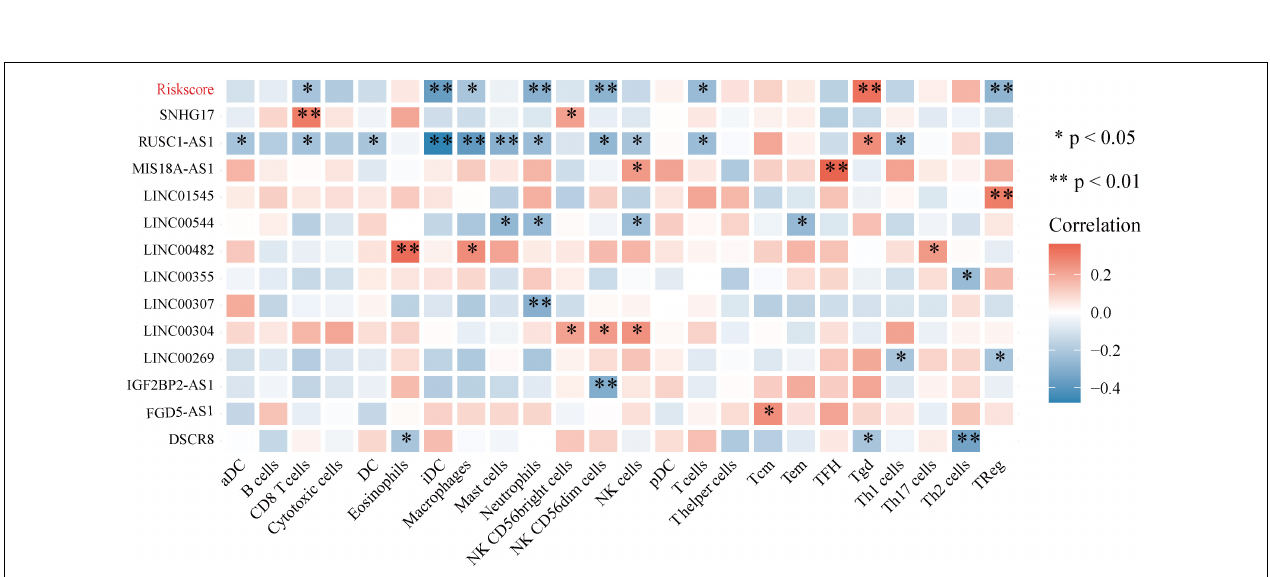
FIGURE 11 | Effects of immune cell infiltration on the prognosis of osteosarcoma patients. Low levels of cytotoxic cells, macrophages, T cells, Th1 cells, DCs, neutrophils, TFH, iDC, NK CD56 dim cells, and Tregs, were associated with poor osteosarcoma patient prognosis. High levels of Th2 and Tgd cells were associated with poor prognosis in osteosarcoma patients.